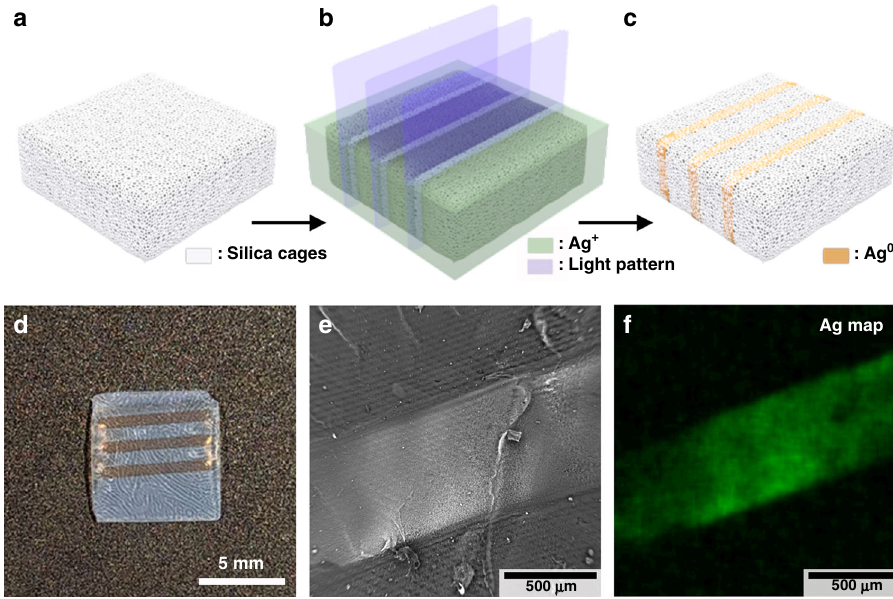
Fig. 6 Internal printing. a – c Illustration of the internal printing of silver within a primary part printed with porous silica cages. First, a block of silica cages without additional functionalization is printed ( a ). The block is immersed in a solution of silver nitrate and photoinitiators. A light pattern in the shape of slabs is then projected onto this block ( b ), resulting in the localized reduction of Ag + ions into Ag 0 ( c ). d Photograph of the resulting block of silica cages exhibiting three slabs of metallic silver. Backscattered electron-based SEM image ( e ) and EDS map ( f ) of a silver slab embedded in the porous silica